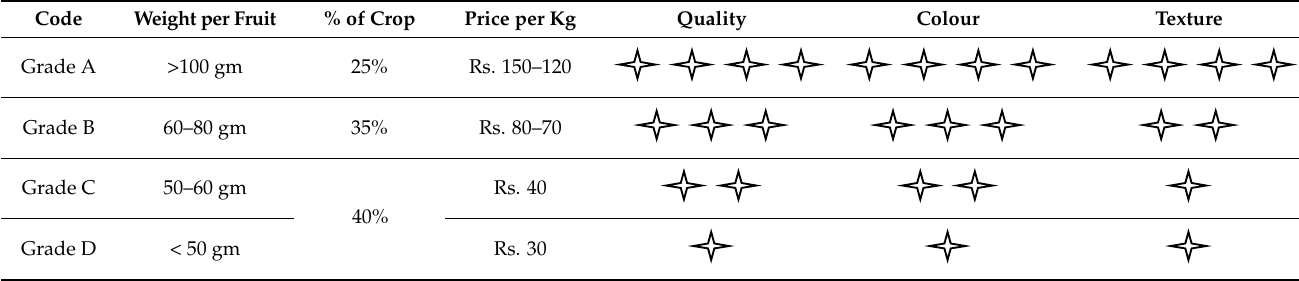
Table 3. Grading of kiwi fruits based on quality, color, and texture. The maximum stars indicate parameters for best quality, maximum color, and great texture. The format of fruit product grading is an important process for farmers and growers because it affects fruit quality assessment in the domestic and international export markets. Grading and sorting are time-consuming, labor-intensive, error-prone, and tedious processes. As a result, an efficient fruit grading system is